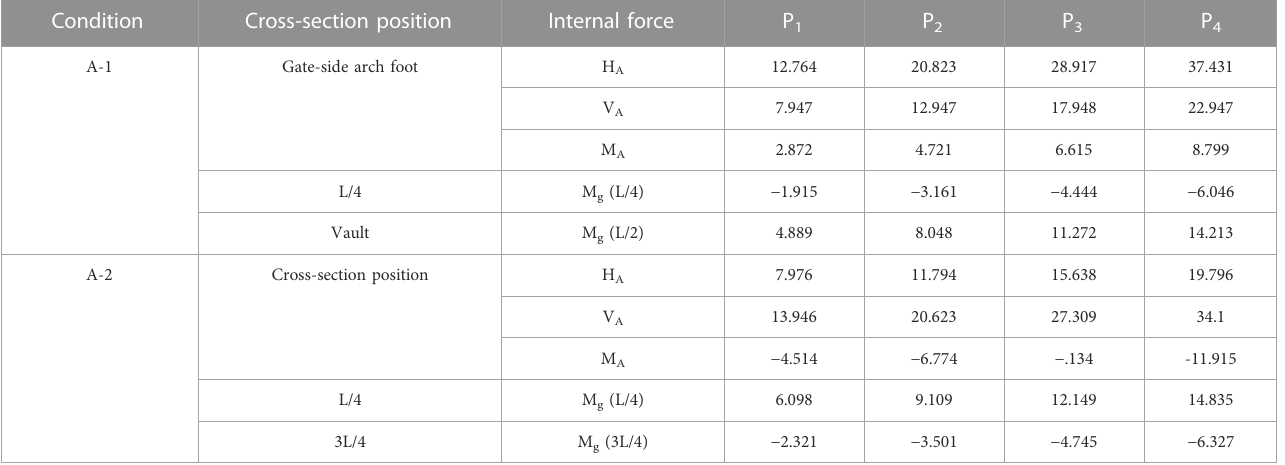
TABLE 11 Measured values of geometric non-linear internal forces (unit: kN m). Condition